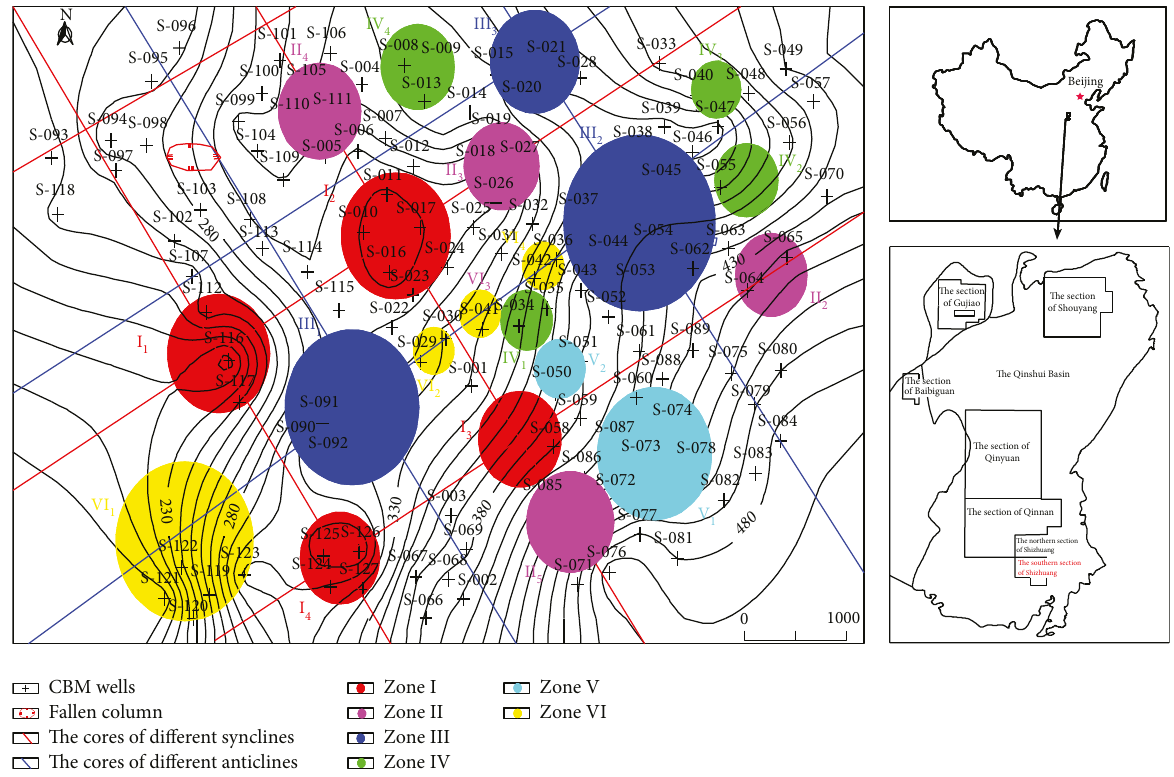
Figure 1: The superimposed partition of di ff erent tectonic regions in the central of the southern part of